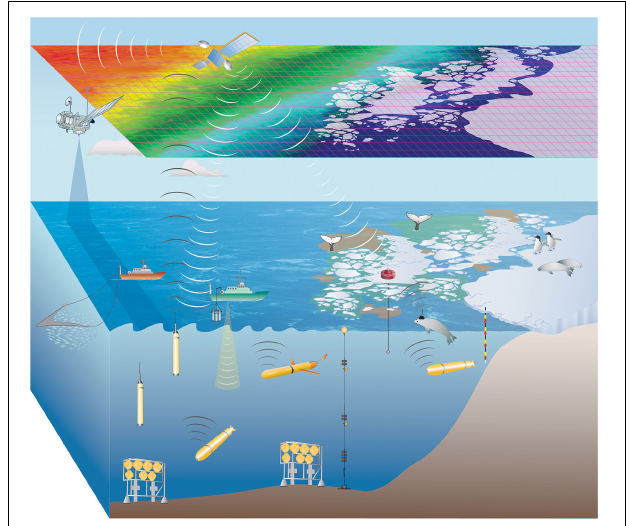
FIGURE 1 | Schematic of a cyberinfrastructure-based vision for SOOS (Meredith et al., 2013; reproduced with permission). Combined with satellite remote sensing, data from both autonomous and non-autonomous platforms would be relayed to ground stations in real time. Assimilating ocean models would produce near-real time state estimates of each of the parameters in the system and associated error fields would then be used to re-task the autonomous platforms in real time. This will maximize the spatial–temporal coverage of each of the parameters being measured, without specific need for human intervention.